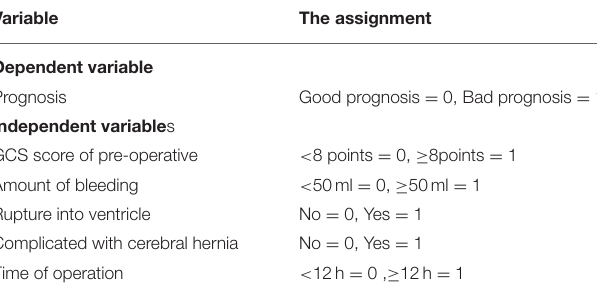
TABLE 5 | Assignment of independent risk factors affecting the prognosis of patients with hypertensive intracerebral hemorrhage (HICH). Variable